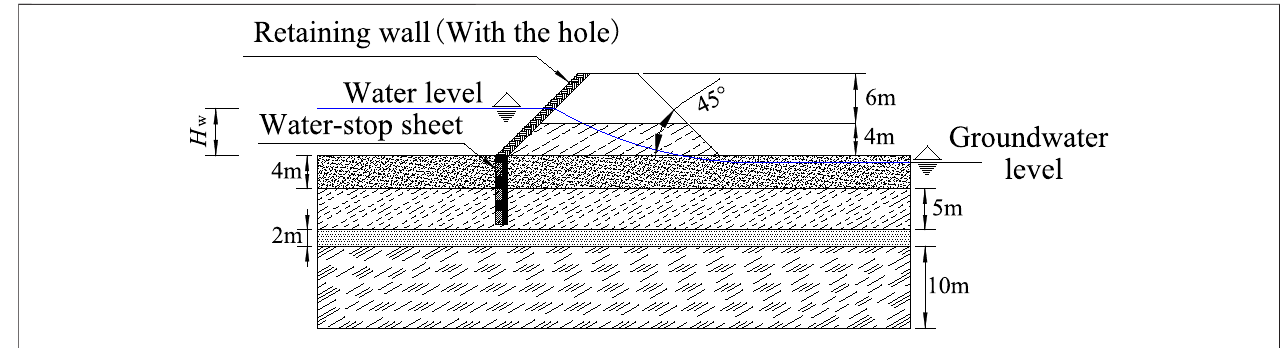
FIGURE 7 | Generalized model of the